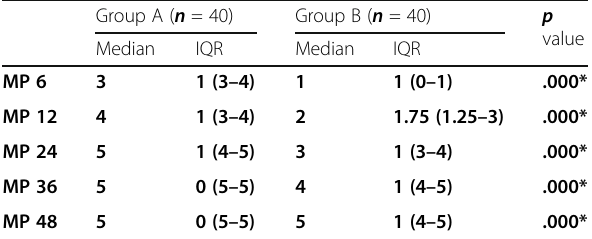
Table 2 Motor power comparison between the two study groups at different time